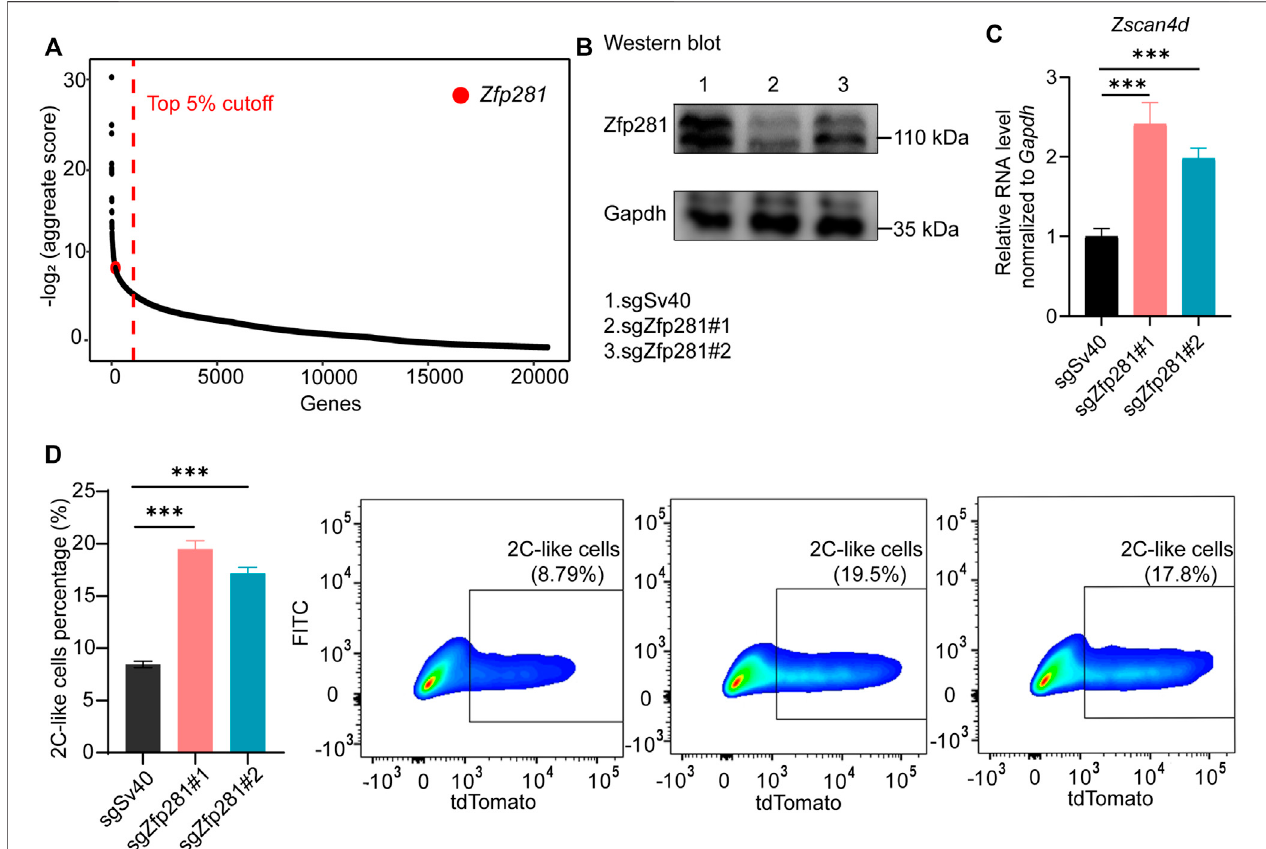
FIGURE 1 | Zfp281 regulates the 2C-like transition of mESCs. (A) The sgRNA count enrichment from the published negative CRISPR-Cas9 genomic screen (Fu et al., 2019). Zfp281 is one of the top candidates inhibiting the 2C-like transition in the screen. (B) Western blot con fi rming ef fi cient Zfp281 (bottom band) perturbation.